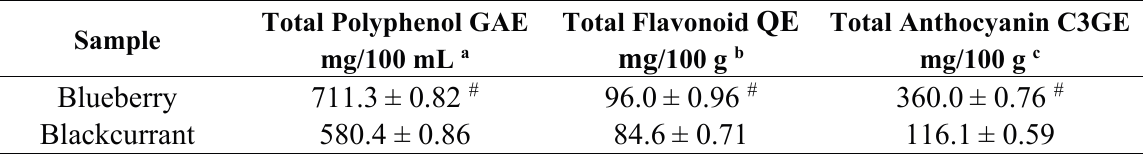
Table 2. Total polyphenol, flavonoid and anthocyanin content in analyzed